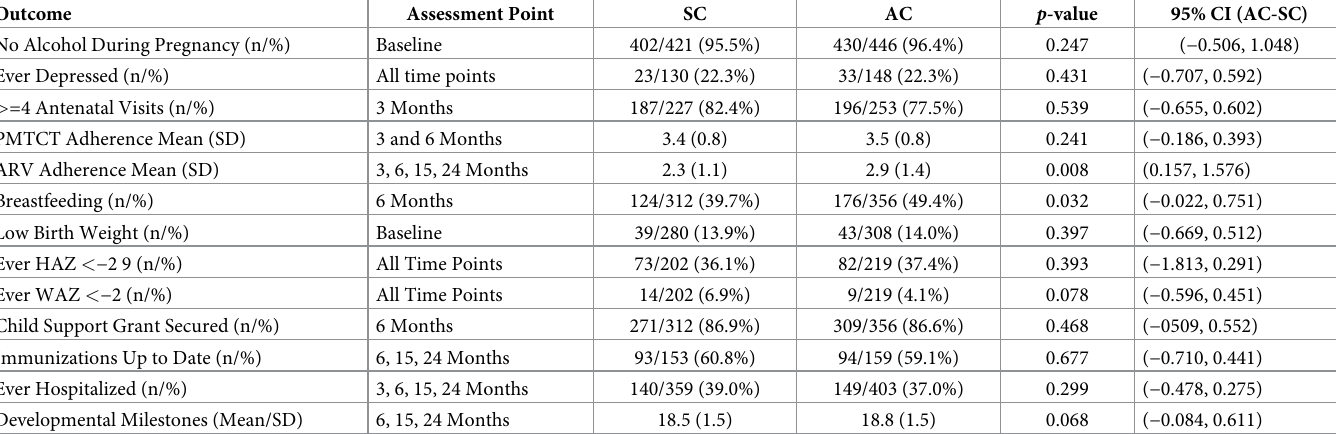
Table 3. Summary of the measures contributing to the primary outcome, grouped by the SC condition and the AC condition 1 .